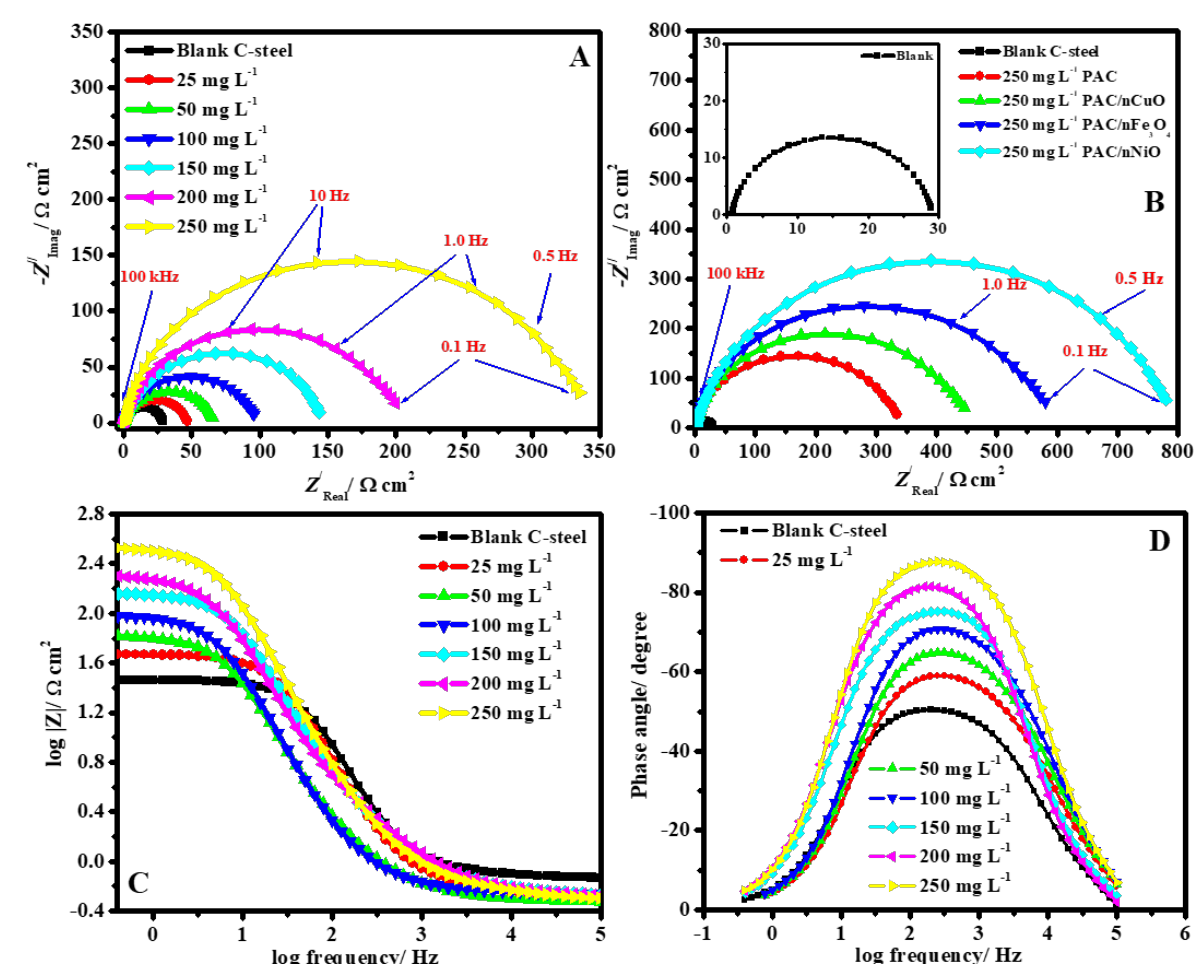
Figure 8. Impedance plots for C-steel in 1.0 M HCl solution; ( A ) Nyquist in the absence and presence of different concentration of PAC, ( B ) Nyquist in the absence and presence of 250 ppm of different nanocomposite inhibitors, ( C ) Bode and ( D ) phase angle representations in the absence and presence of different concentration of PAC at 50 ◦